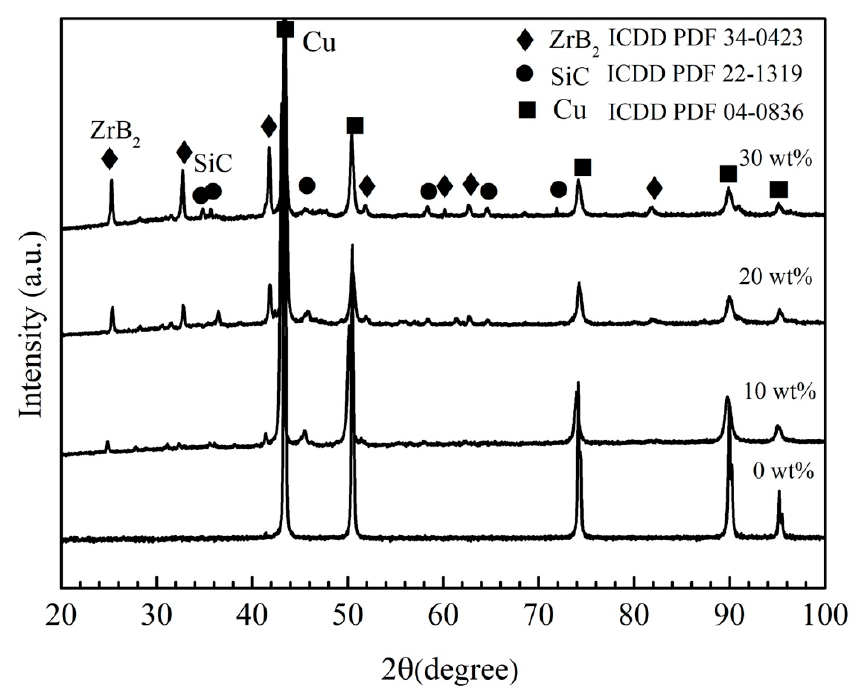
Figure 5. The X-ray diffraction phase analysis of laser cladding composite coating.